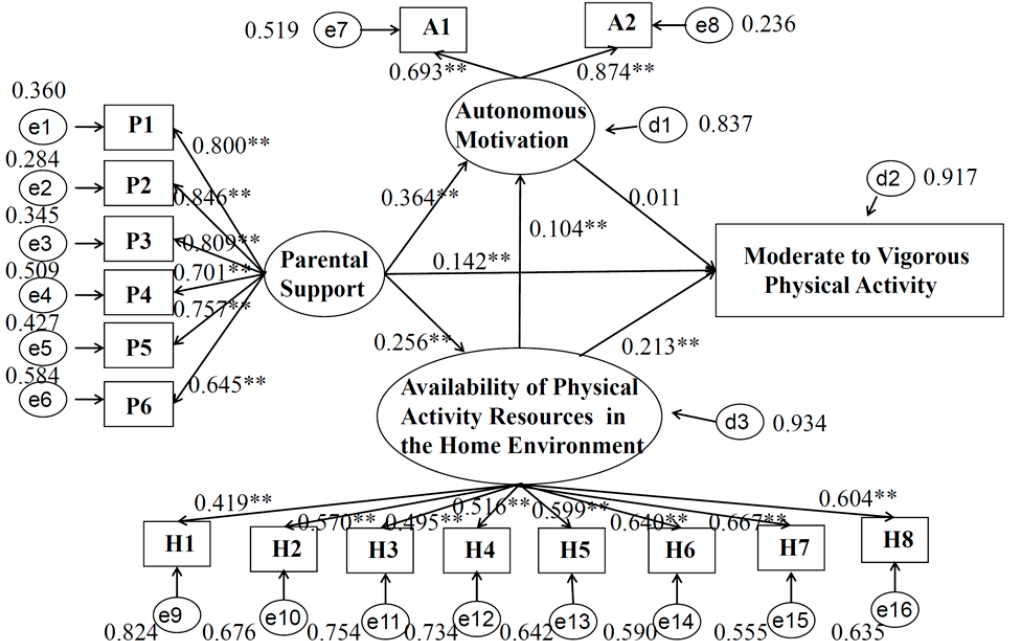
Figure 3. Path model of moderate to vigorous physical activity for girls. Note: ** p < 0.001. P1, “a.